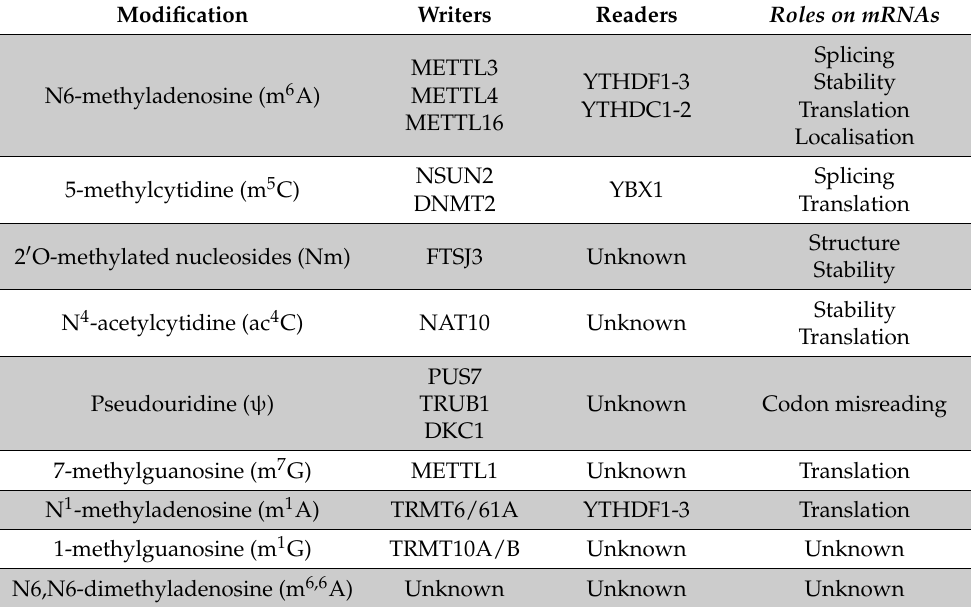
Table 1. A summary of writer and reader proteins for common mRNA modifications and the proposed roles for these modifications on human cellular